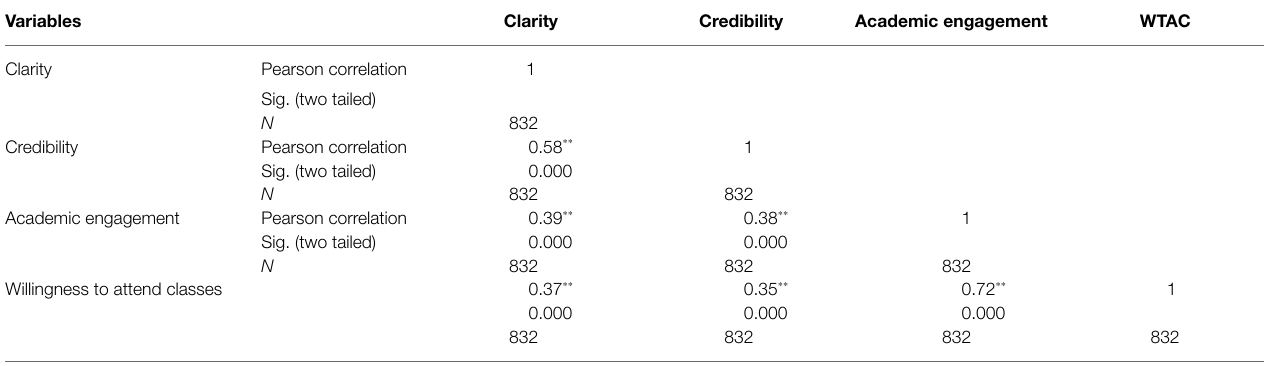
TABLE 4 | Results of Pearson correlation between overall teachers’ clarity and credibility and students’ academic engagement and willingness to attend classes. Variables Clarity Clarity